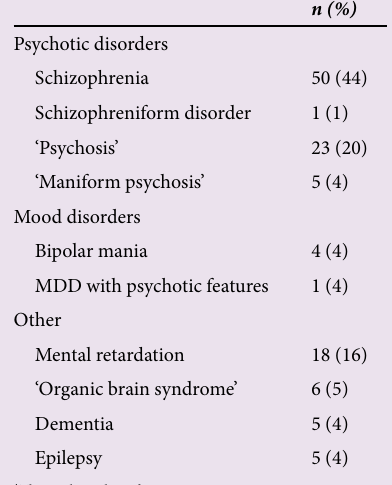
Table 2. Details of the offence Table 3. Psychiatric